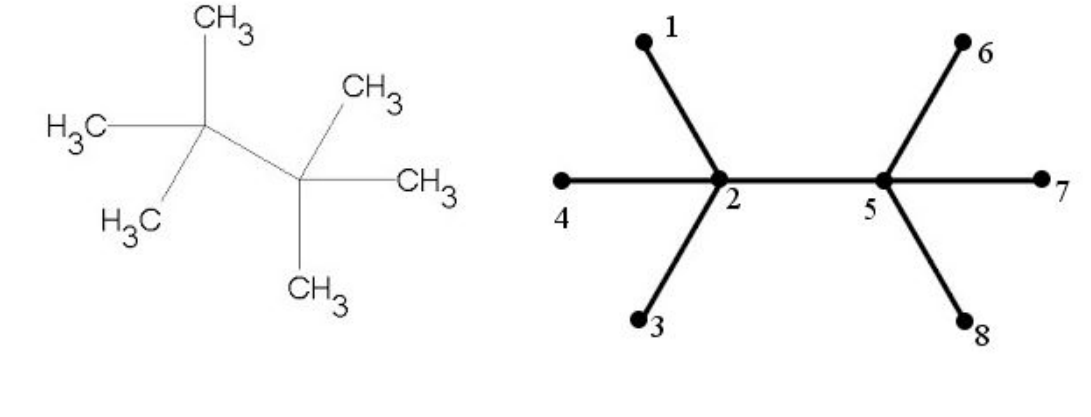
Fig. 1 2 , 2 , 3 , 3 − tetramethylbutane and its molecular